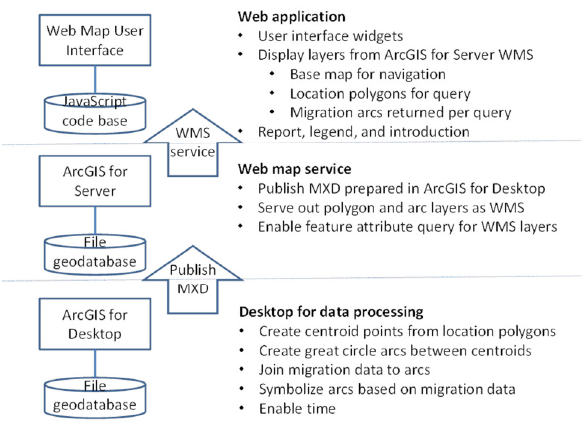
Figure 2 summarized the data processing work flow on ArcGIS for Desktop.